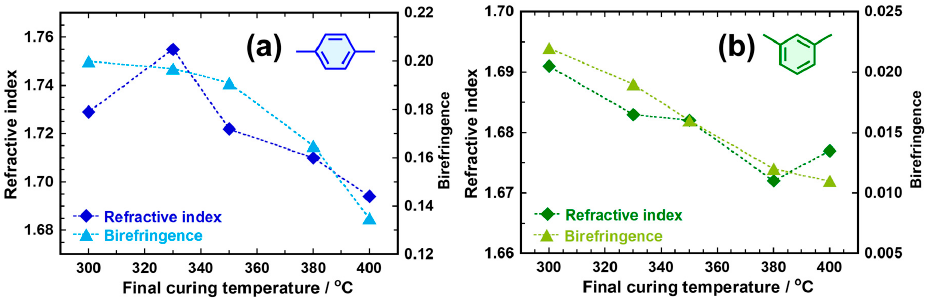
Figure 4. Final curing temperature dependence of average refractive indices ( n av ) and in-plane/out- of-plane birefringence ( ∆ n ) for ( a ) PPD-PIs and ( b ) MPD-PIs.